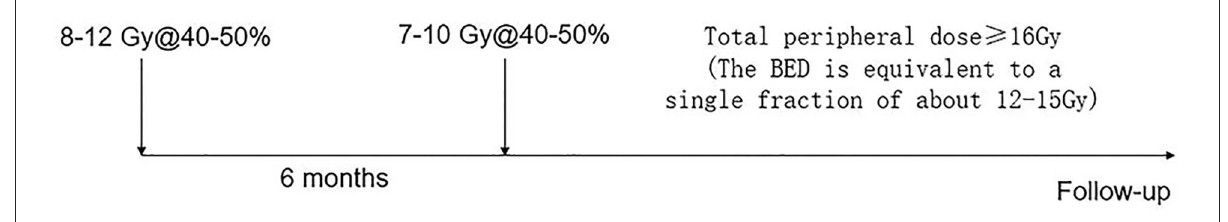
FIGURE1 The treatment protocol for two-staged radiosurgery for meningiomas in this series is ∼ 6-month interval between